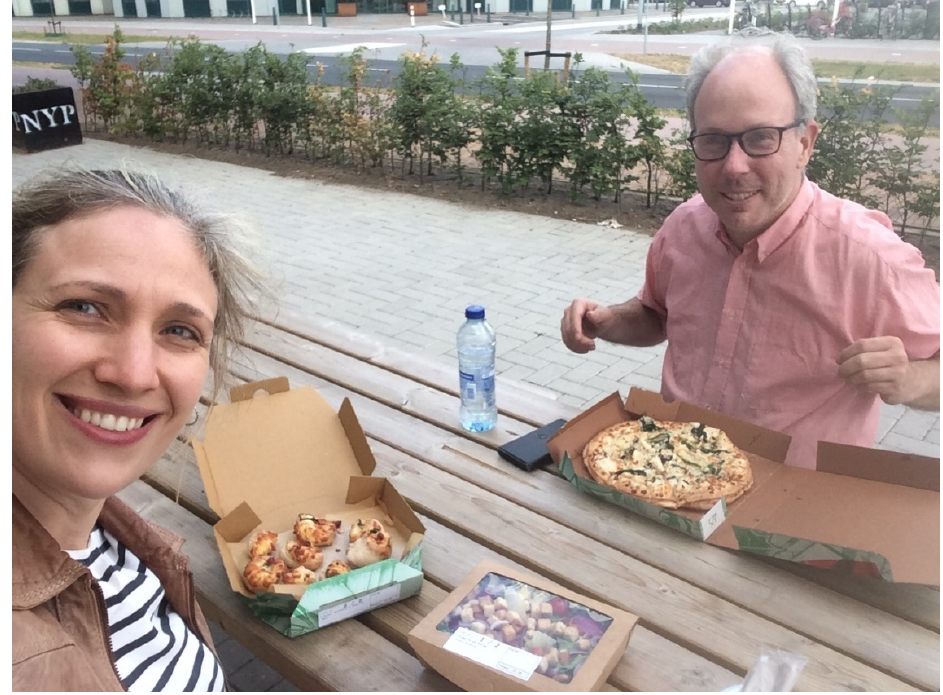
Figure 1. Going for pizza (10 July 2018).